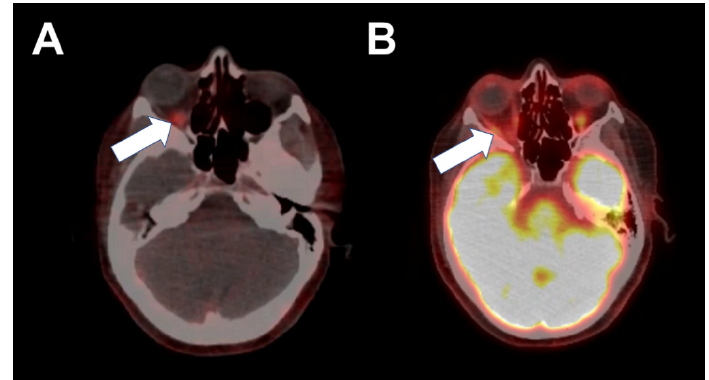
Figure 1. Abnormal intense 18F-FES activity in the right posterior orbit ( A , arrow), corresponding to known right oculomotor nerve, right medial rectus, and superior aspect of the right inferior rectus. Normal physiologic 18F-FDG activity in the right extraocular muscles ( B , arrow).